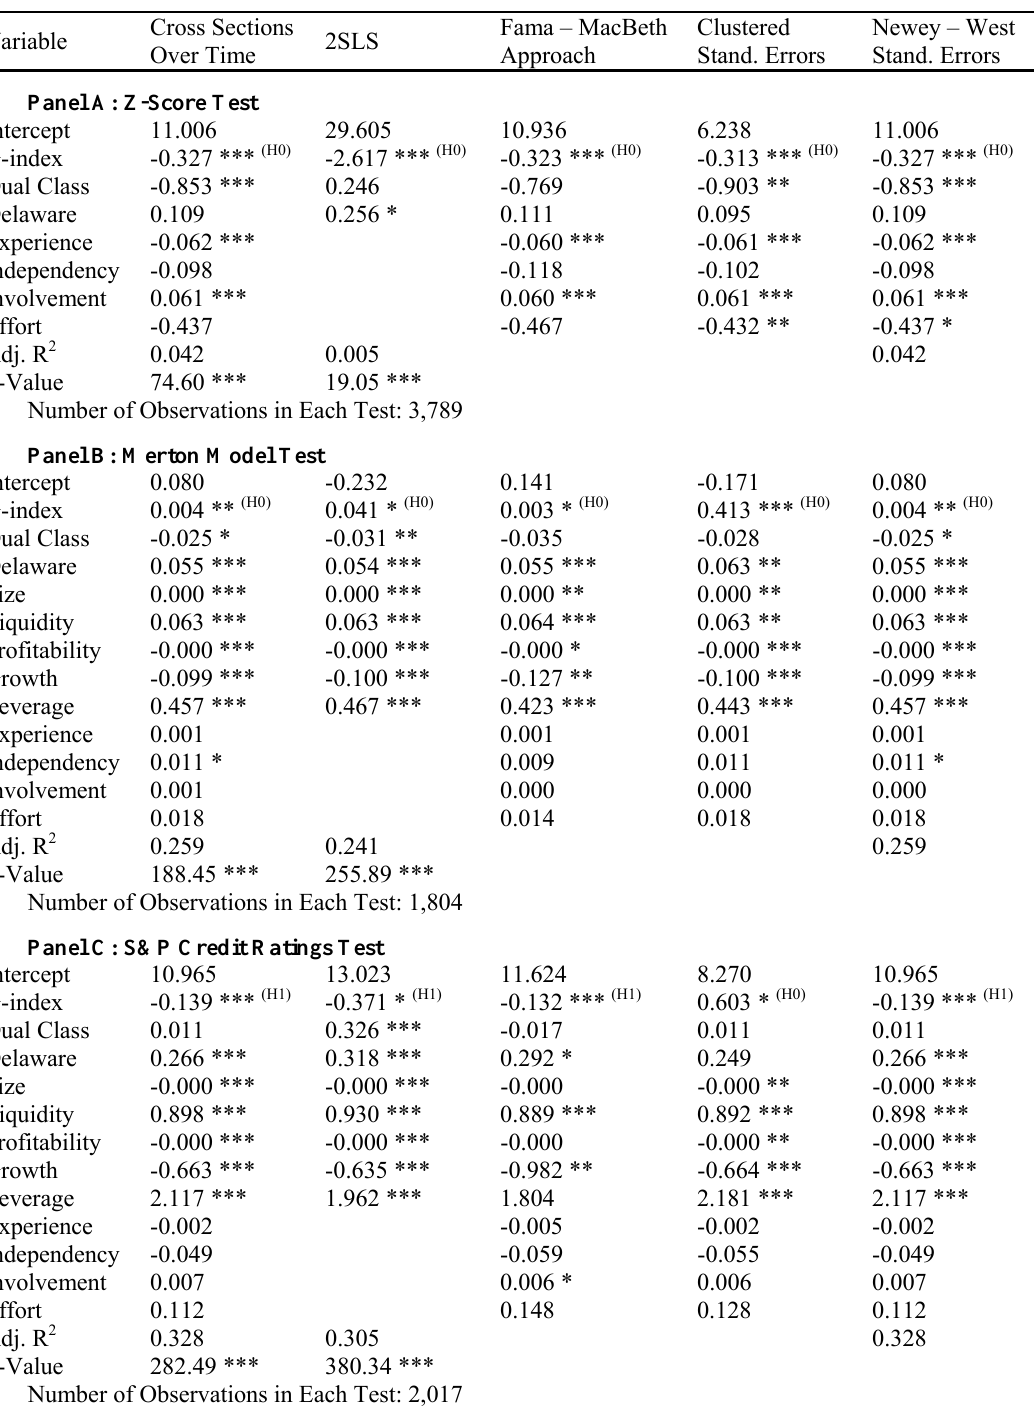
Table 3. Summary Results for the G-Index